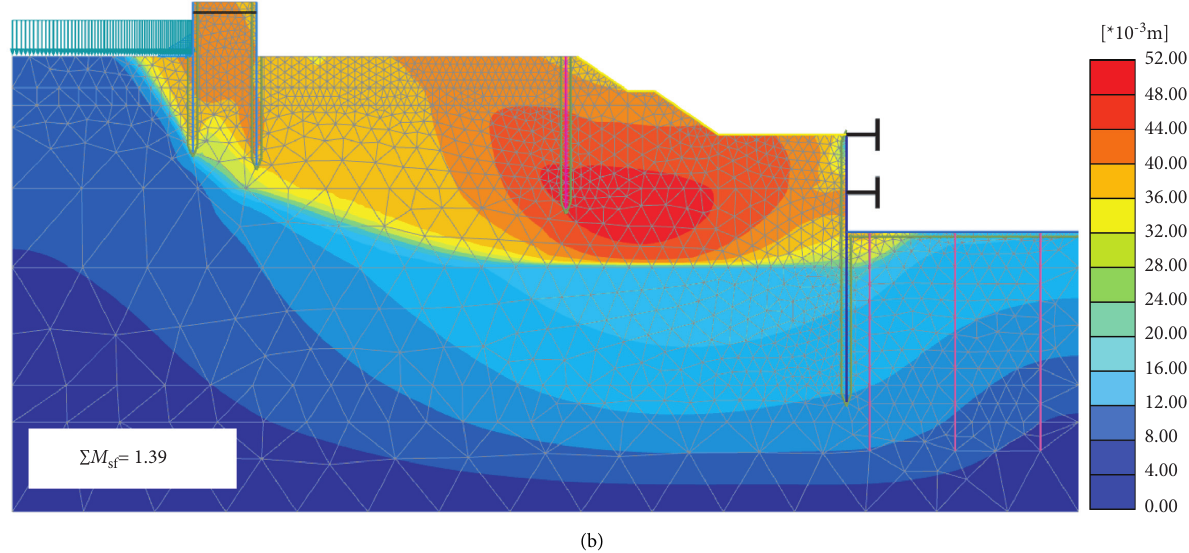
Figure 22: Effect of seepage force on the deformation of piles. (a) Actual numerical case and (b) hypothetical numerical